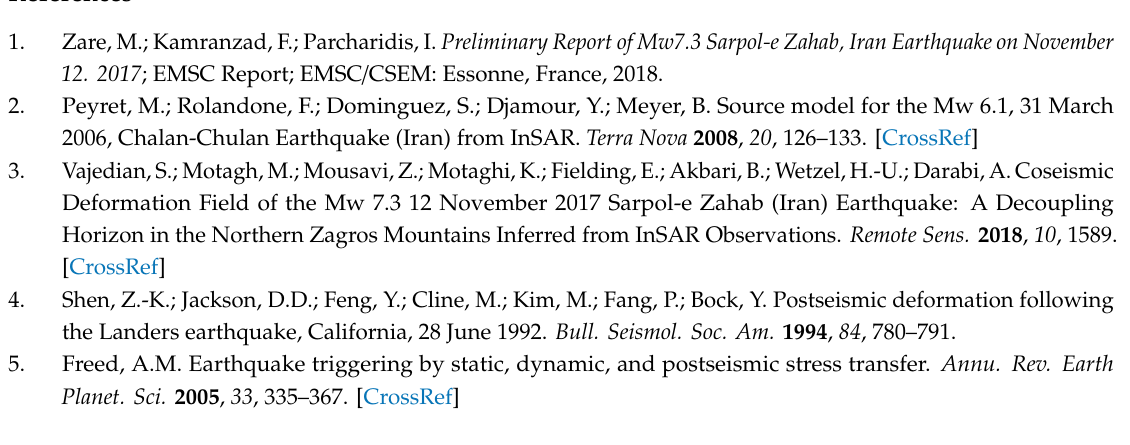
Figure S1: coseismic displacement field caused by the aftershock of 25 August 2018; Figure S2: uniform slip inversion result for afterslip for time period 2; Figure S3: conceptual model of the spatial relationship between coseismic fault slip and afterslip for time period 2; Figure S4: sampled data used for modelling of aftershock sequence 1 and aftershock sequence 2; Figure S5: same as Figure S4 but for time period 1 and time period 2; Table S1: reported ratio of the afterslip moment release relative to the coseismic moment release and the position of afterslip relative to the coseismic slip; Table S2: rheologic structures inferred in previous studies; Table S3: range, optimal and uncertainties of InSAR-inversion fault slip parameters for the afterslip for time period